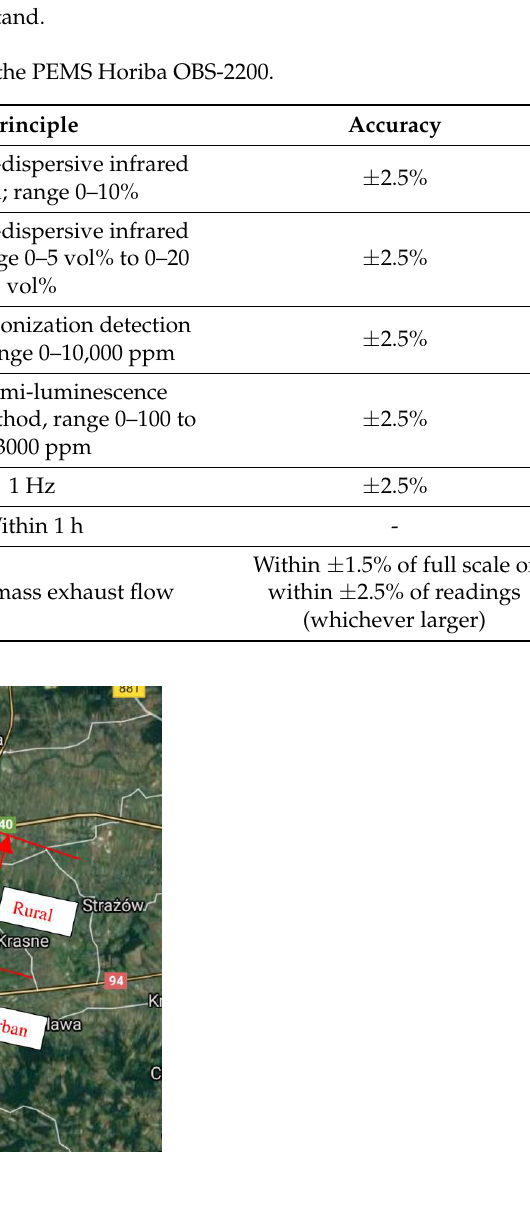
Table 2. Properties of tested fuels, where MON = motor octane number; and RON = research octane number.